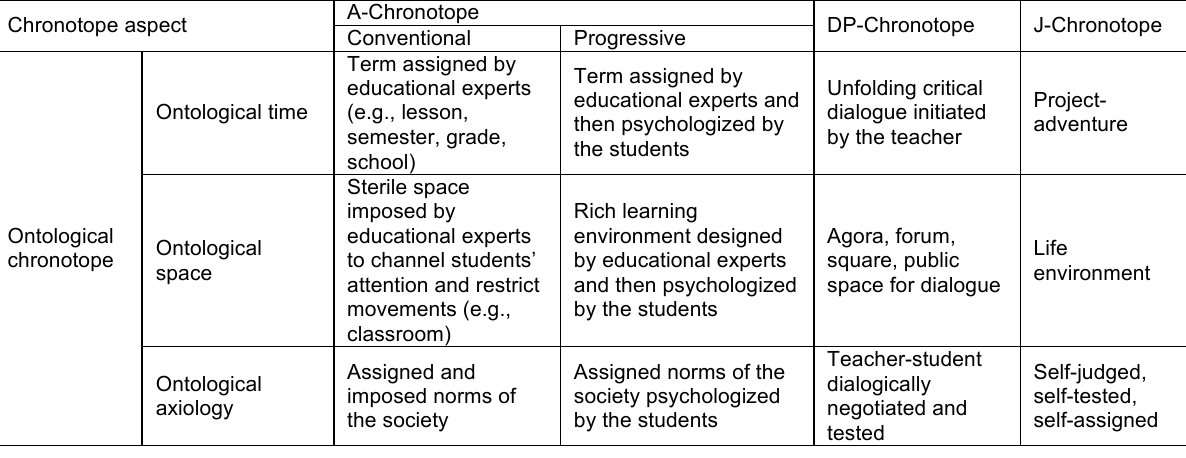
Table 1. Major espoused educational